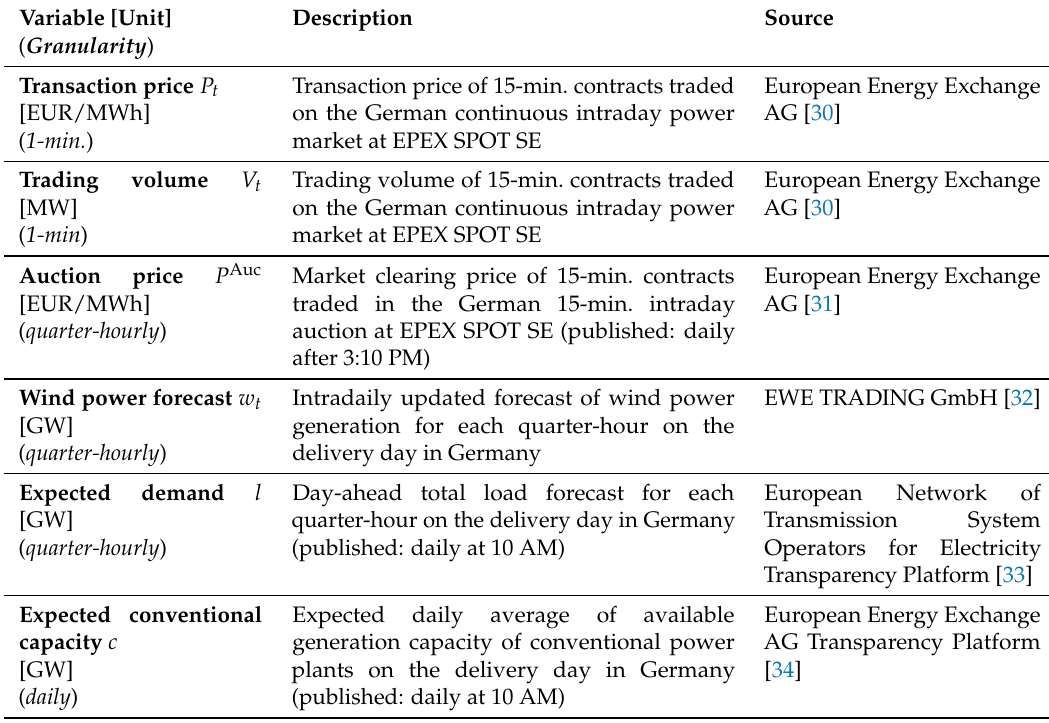
Table 1. Summary of explanatory variables, granularities, detailed descriptions and data sources. Variables indexed by t vary over the continuous intraday trading session of a 15-min.